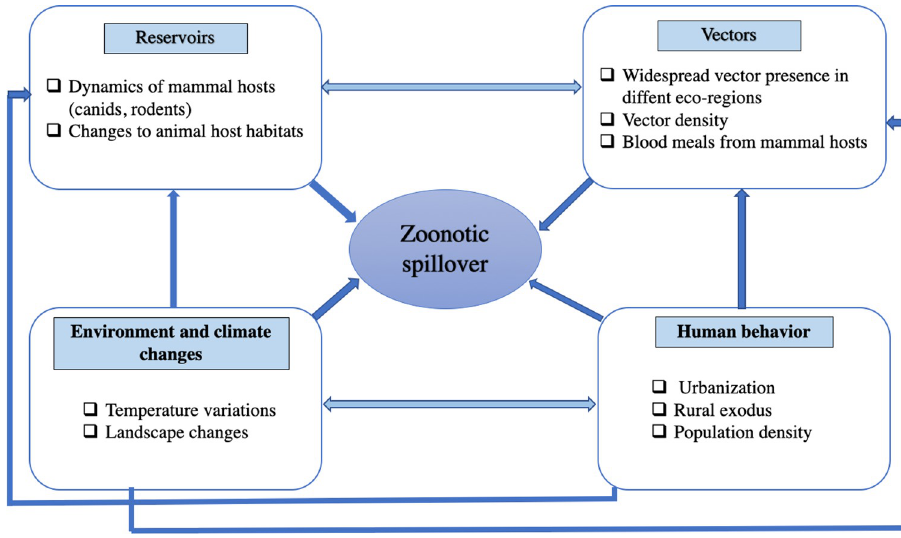
Fig 2. Network of factors that could lead to a zoonotic spillover of L . tropica from one of the potential mammalian hosts in Morocco.